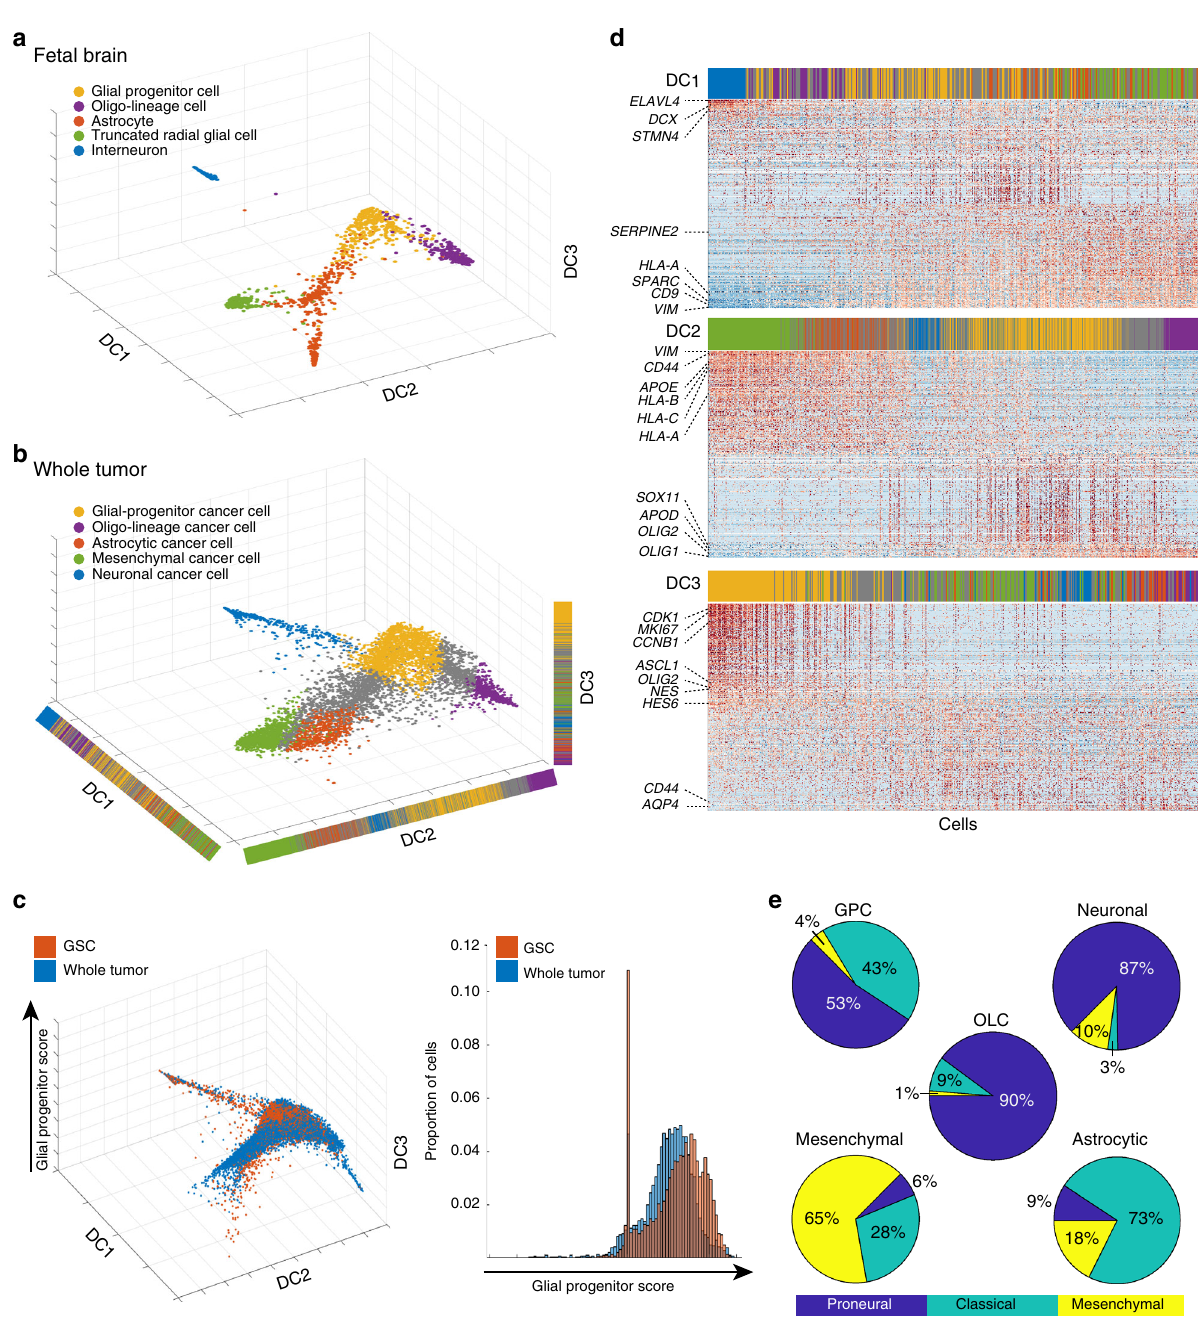
Fig. 3 Fetal brain roadmap reveals a glioblastoma trilineage hierarchy centered on progenitor cancer cells. a Diffusion plot of the projection of selected fetal cell types onto the roadmap. Cells are colored by the cell type they were attributed in Fig. 2a. b Diffusion plot of the projection of an equal number of whole-tumor cancer cells from each patient onto the roadmap. Cells are colored based on their classi fi cation by linear discriminant analysis (LDA). Unclassi fi ed cells were colored gray. c Diffusion plot showing the location of glioma stem cells (GSCs) relative to whole-tumor cells (left) and histogram of glial progenitor score for GSCs and whole-tumor cells (right). An increase in proportion of cells with higher glial progenitor scores is seen in GSCs ( p < 1e- 21, two-sample Kolmogorov – Smirnov test). Only samples with paired GSC and whole-tumor data were used here. d Heatmaps showing relative gene expression (raw data) for cells ordered by each of the diffusion components of the roadmap. Genes are ordered from most correlated to least correlated with the diffusion component. The 200 most and 200 least correlated genes are shown. Top color bar indicates cell type classi fi cation from the LDA. Each color corresponds to the same classi fi cation as in b . e Pie chart for TCGA subtype by cell type for a subset of 1000 cells. Cell types are based on the LDA classi fi cation for all whole-tumor cells. and TCGA subtype was obtained using Gliovis (see